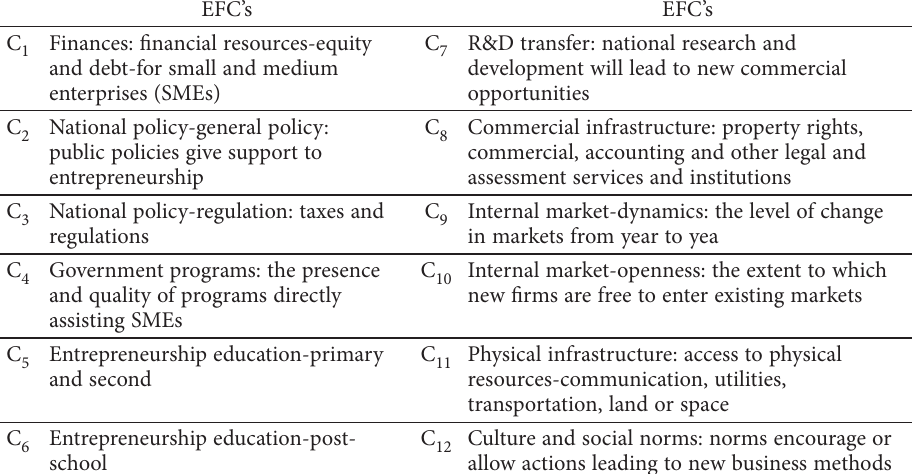
Table 2. Key entrepreneurial framework conditions (EFC’s) EFC’s